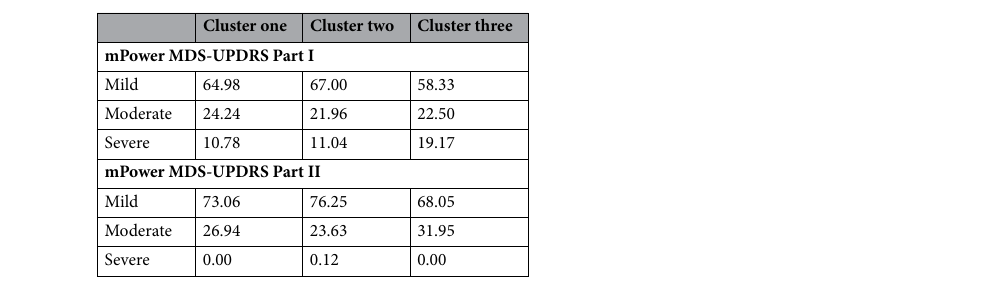
Table 2. Percentage of participants from the mPower MDS-UPDRS I–II in each severity group for the three clusters.